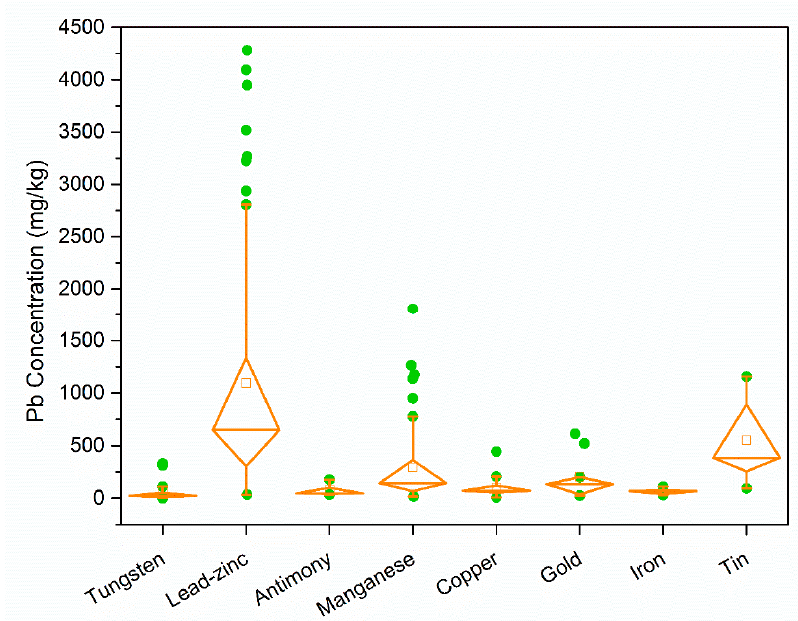
Figure 4. Pb concentrations in soil around different types of mines. Table 2. Geological characteristics of various metal